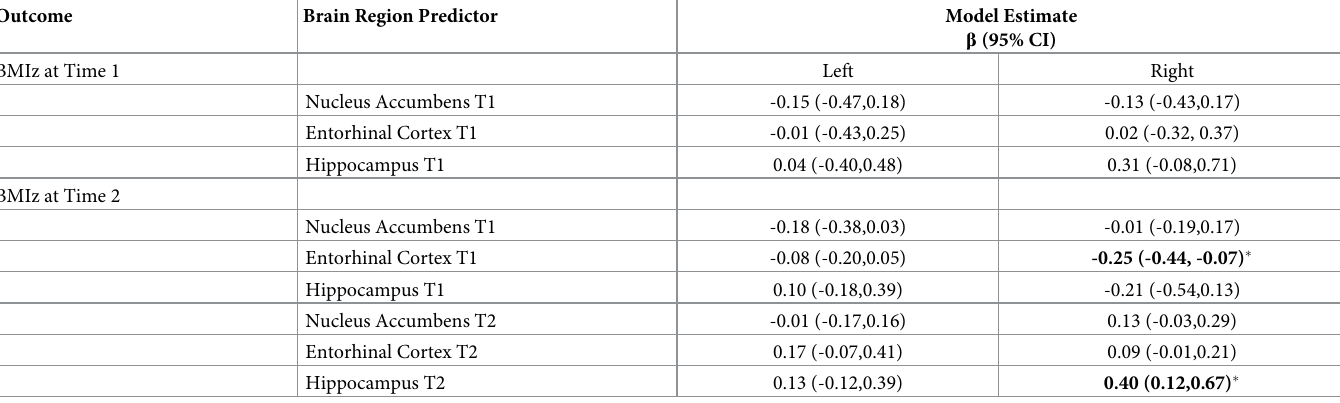
Table 3. Regressions from the SEMs between BMIz scores and regional brain volumes at baseline and 1-year follow up.